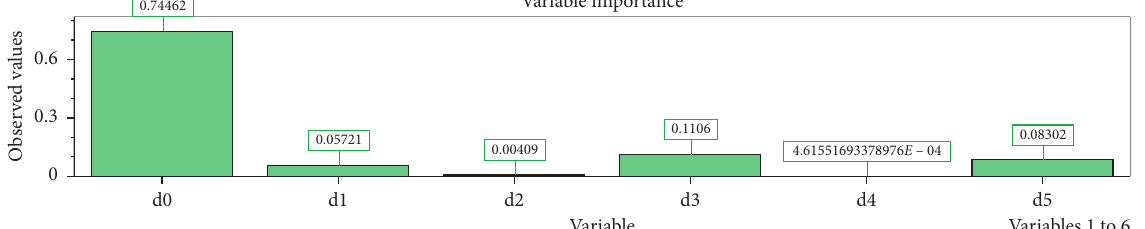
w I w ; (d5) A C ; L ; (d2) P ; (d3) P ; (d4) OMC